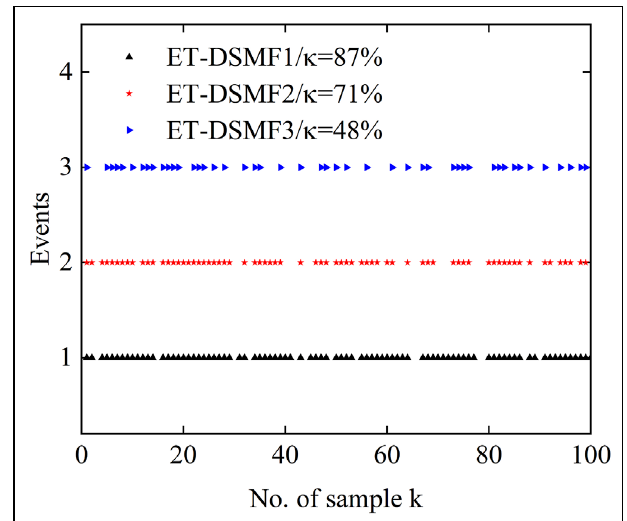
FIGURE 12 | Triggering sequences under different triggering threshold